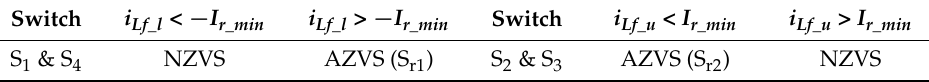
Table 1. Zero-voltage switching (ZVS) types of switches under different output Table 1. Zero ‐ voltage switching (ZVS) types of switches under different output currents.